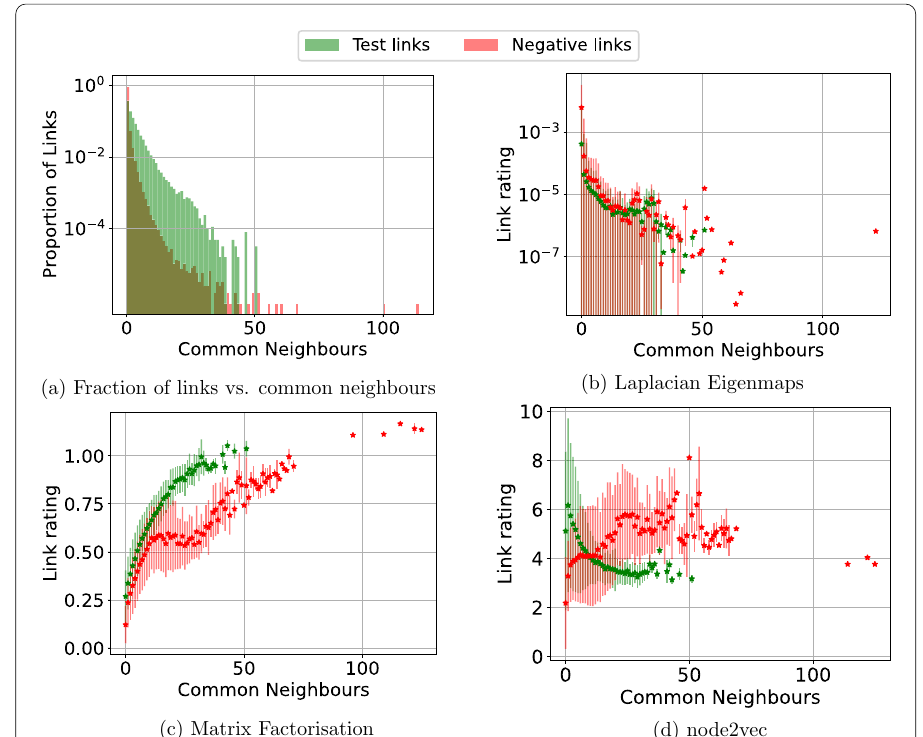
Fig. 3 a Fraction of links of the Hamsterster network (original) that share a given number of neighbours. Average rating of negative and test links with a given number of common neighbours derived by b Laplacian Eigenmaps, c Matrix Factorisation, and d